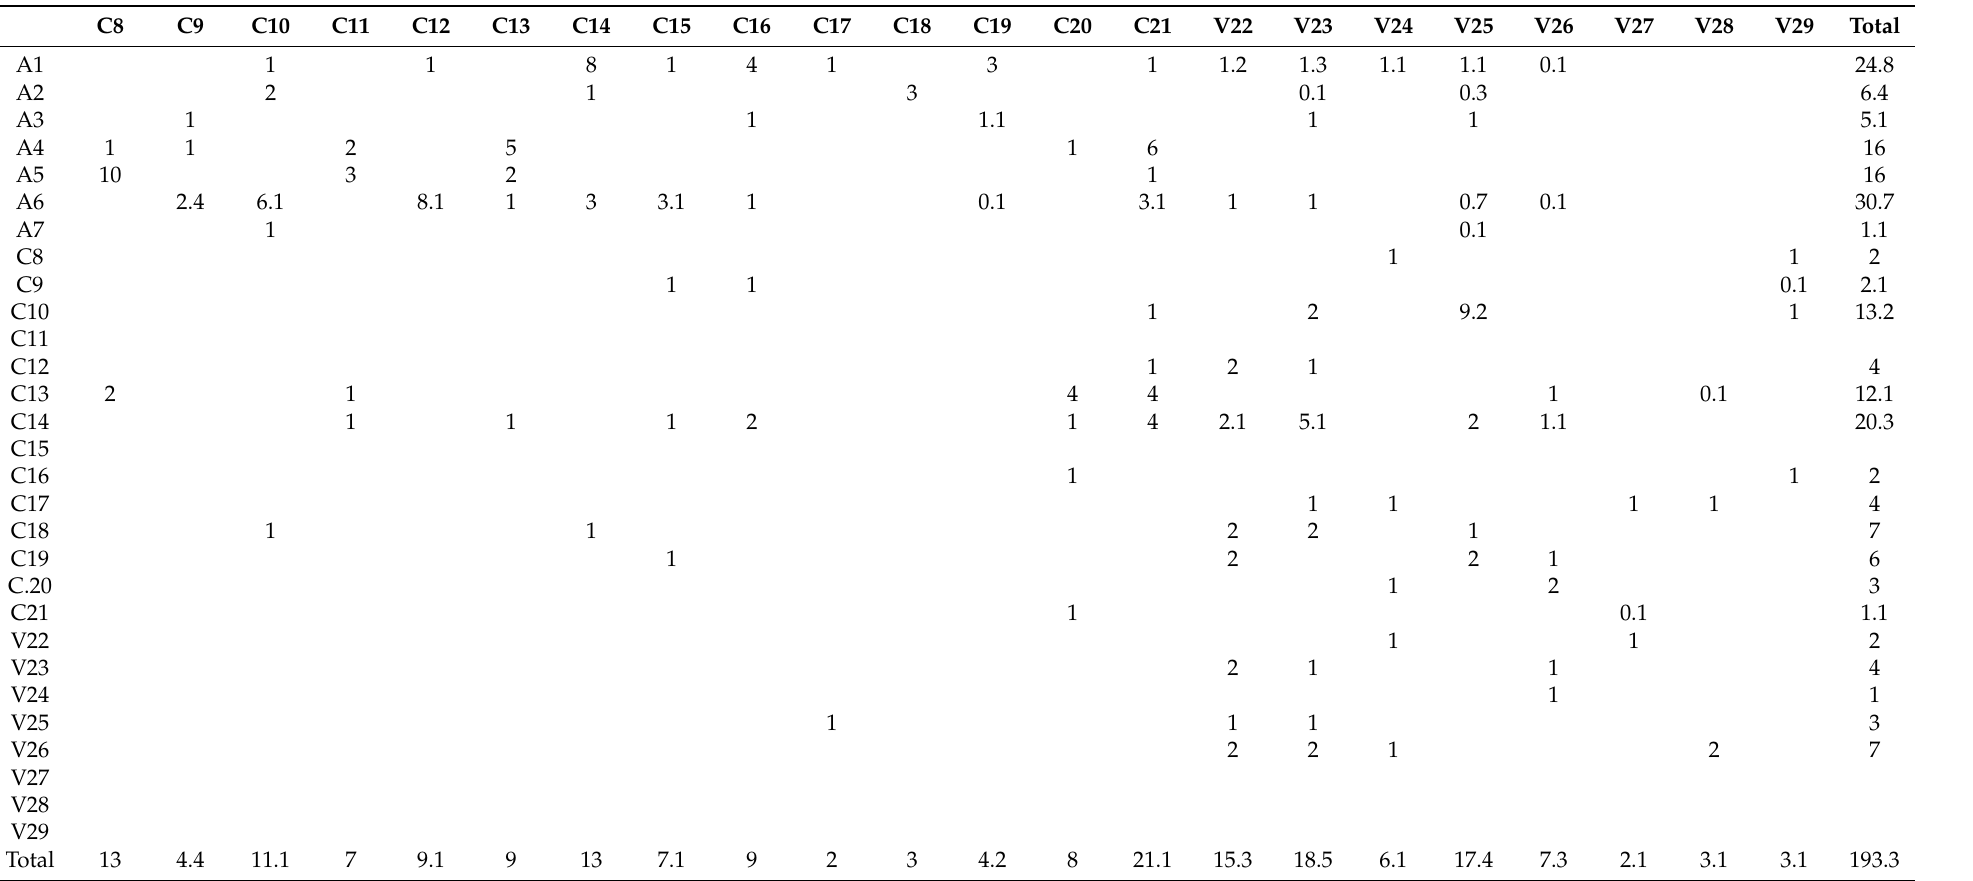
Table A1. Summarised implication matrix for all participants in this